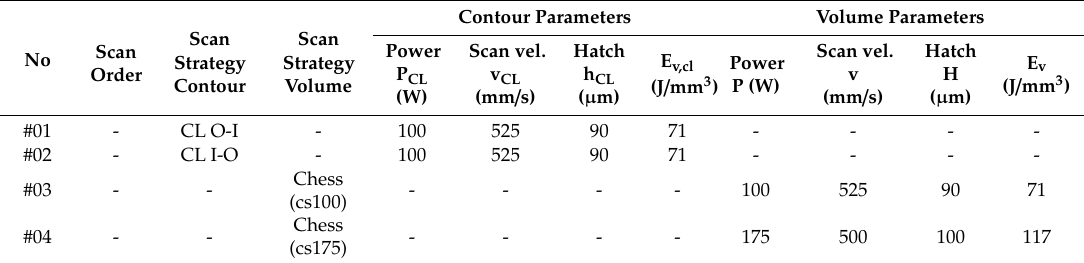
Table 1. Samples built with a single scan strategy of di ff erent scan patterns consisting either of contour or volume scan